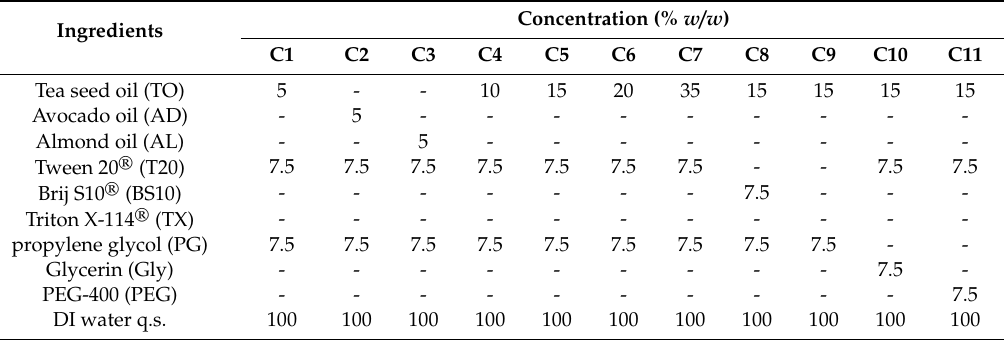
Table 3. Composition of nanoemulsion (NE)